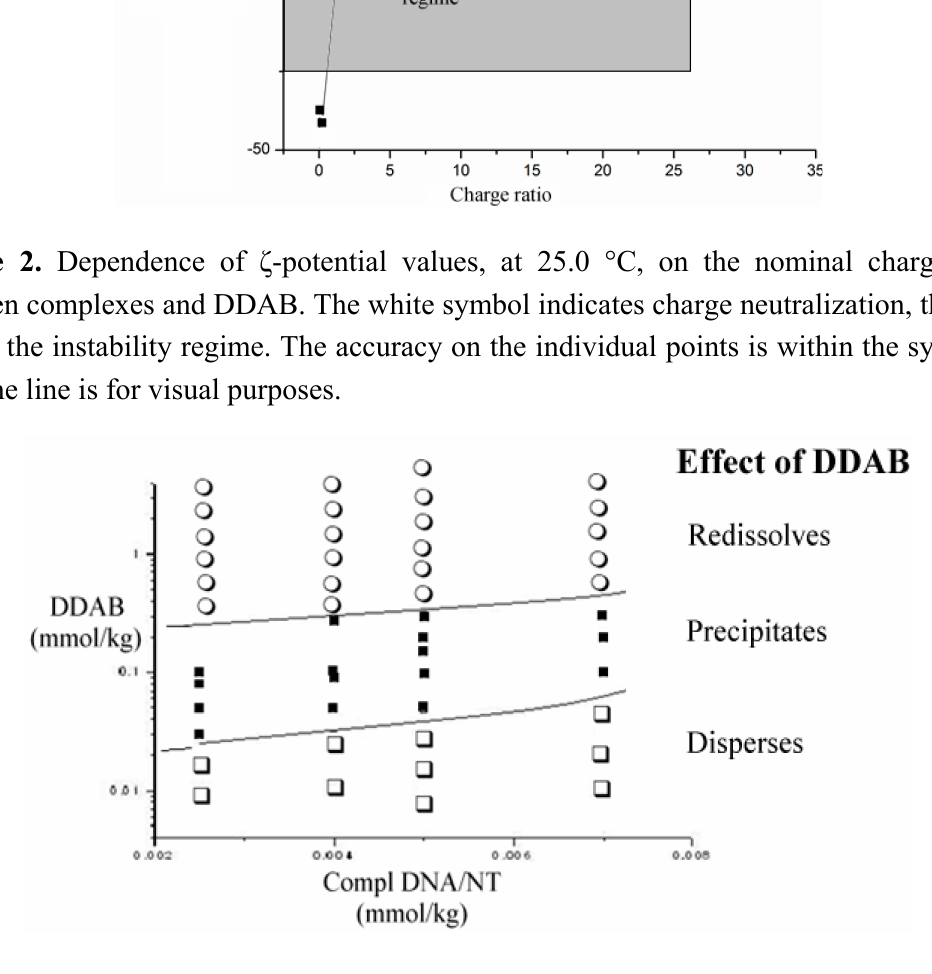
Figure 3. Partial phase map, inferred by optical absorbance, Dynamic Light Scattering (DLS) and ζ -potentials, at 25.0 °C. The location of the phase borders is tentative. Data are reported as the concentration of 1/1 ss-DNA/CNT complex vs. that of DDAB. Errors are lower than the symbols